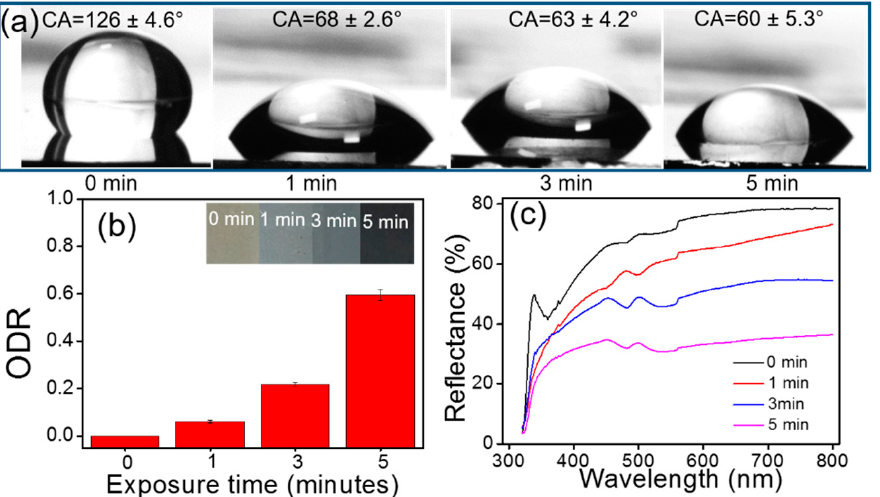
Figure 14. Variation in ( a ) water contact angle and ( b ) optical darkness ratio (ODR); inset shows respective photographs. ( c ) Surface reflectance of AgNR array samples after 5 ppm H 2 S exposure times of 1, 3 and 5 min. Reproduced with permission from [185].